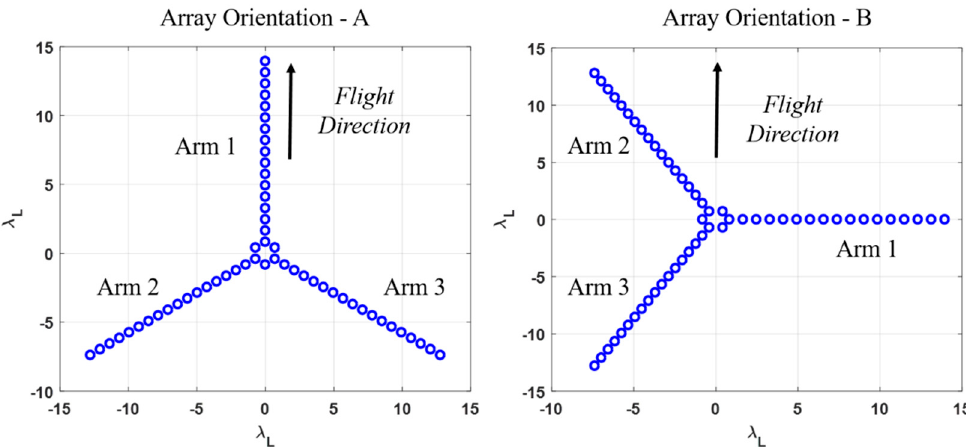
Figure 2. Arrangement of IMR’s antenna array with the spacing of antenna elements normalized to wave length of L-band ( λ L ), and the three arms in the Y-shaped array are label as Arm 1, 2 and 3, respectively. Two di ff erent array orientations are named as A and B, and the flight direction are indicated as black arrows.